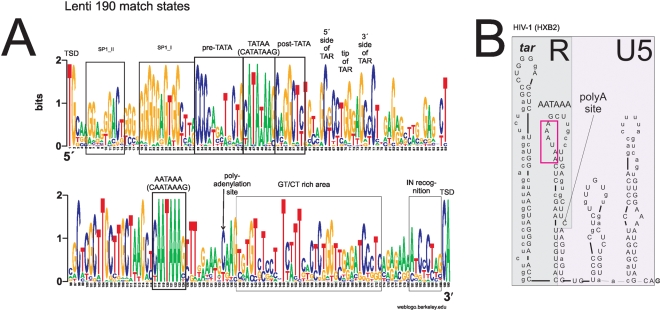
Outcome of the lenti HMM.A. Weblogo for a Viterbi alignment of the lentiviral LTR training set (“lenti”). Conventions are as in Fig 1. Conserved lentiviral landmarks (nef termination, TFBS and other characteristics of the proximal promoter), TATA and AATAAA boxes with their surroundings, TAR, the GT/CT rich stretch and a U5 portion which binds to integrase, are visible. B. RU5 of the HIV-1 hxb2 RNA sequence analysed with the lenti HMM. The conservation (upper case) of the crown and 3′ half of the tar stem loop, AATAAA and polyadenylation sites is shown.